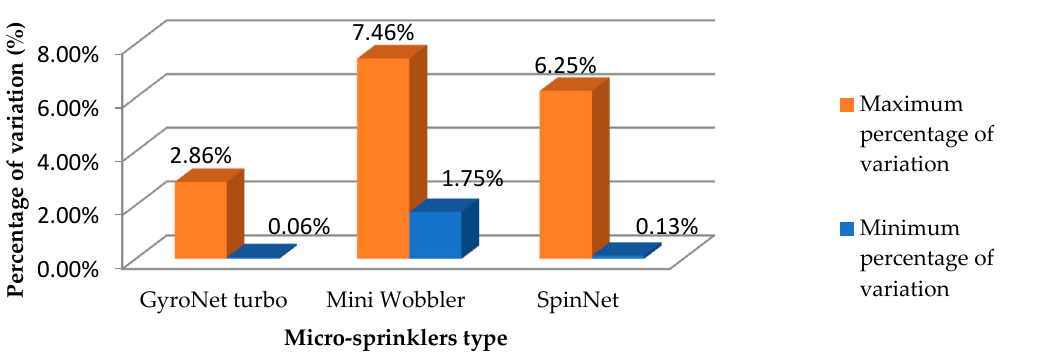
Figure 6. Comparison of micro-sprinklers according to the percentage variation of the coefficients obtained.